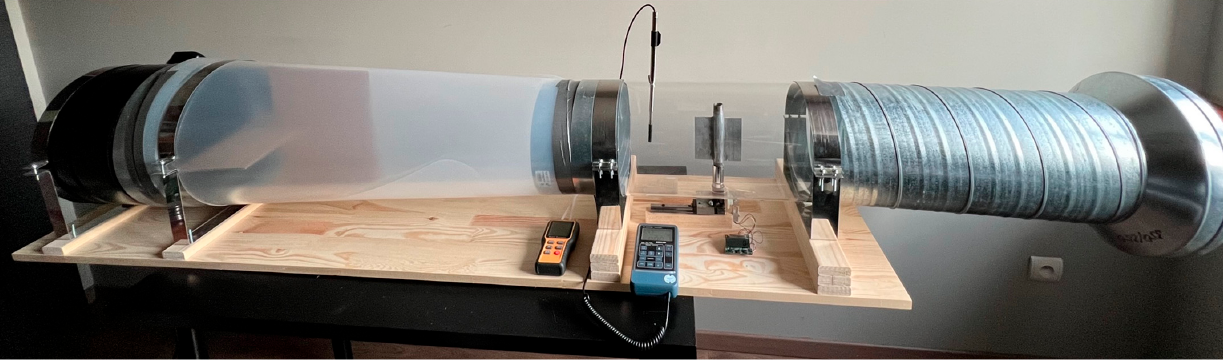
Figure 3. Wind tunnel test stand.